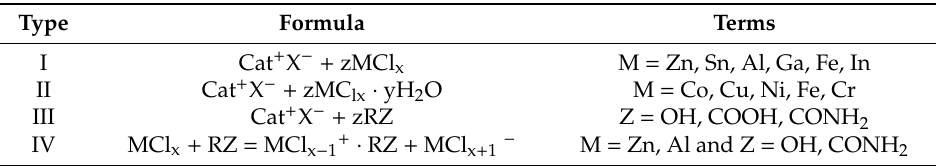
Table 1. The four types of deep eutectic